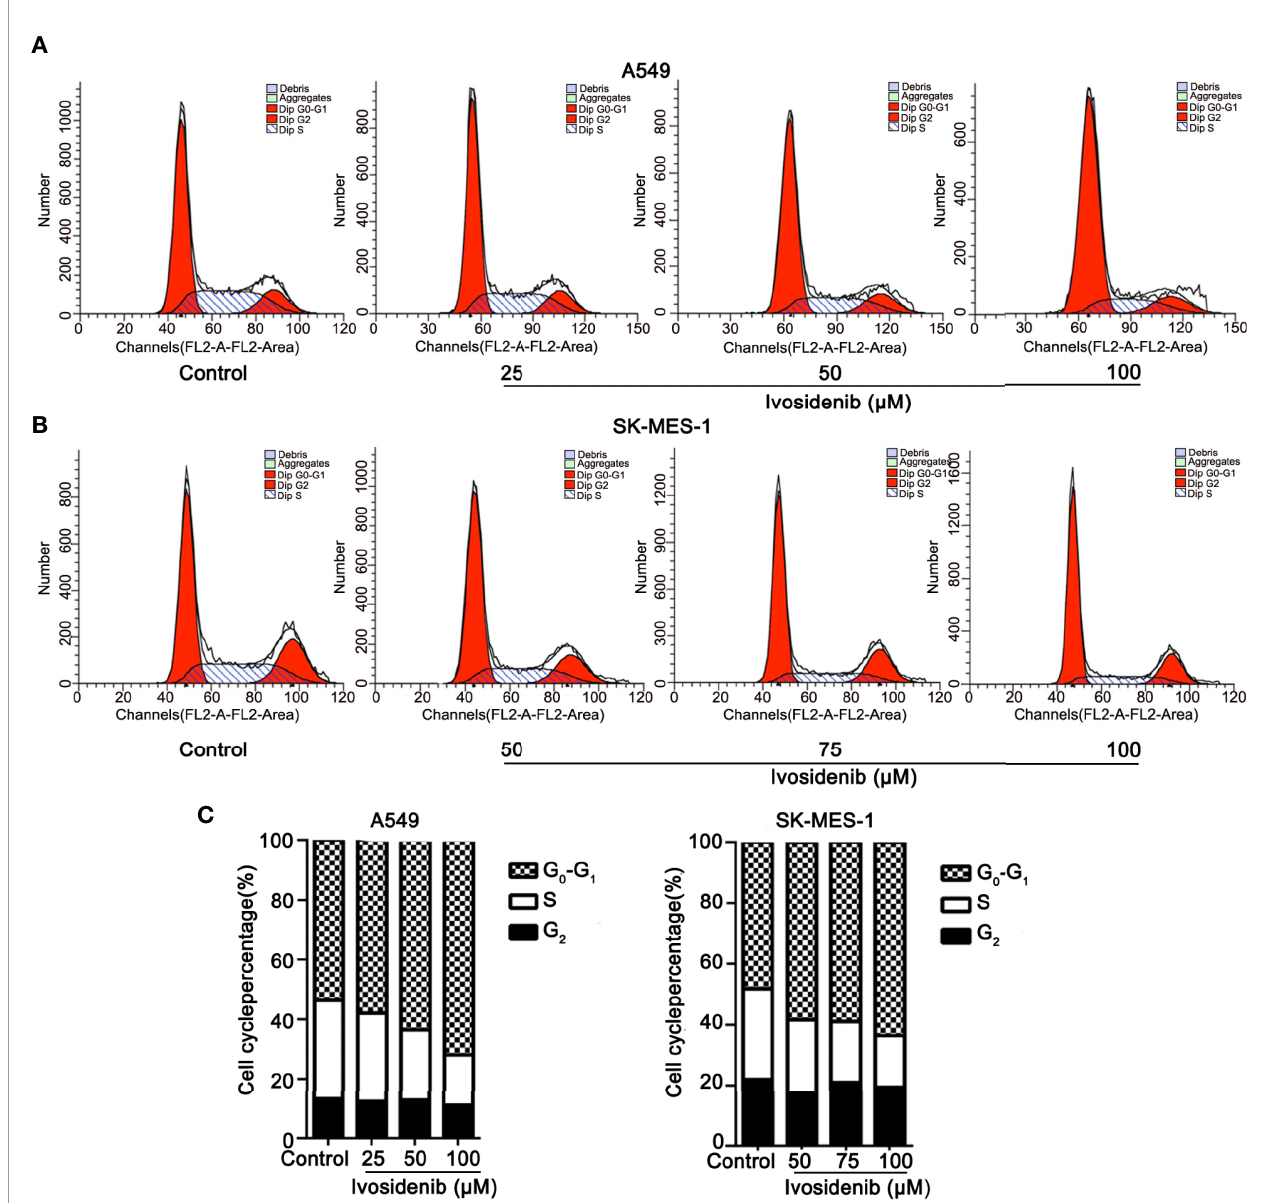
FIGURE 4 | Ivosidenib inhibits the cell cycle in NSCLC cells. (A) Flow cytometric analysis was used to measure cell cycle distributions of A549 cells after 24 h of culture with ivosidenib at 25, 50, and 100 µM. (B) Flow cytometric analysis was used to measure cell cycle distributions of SK-MES-1 cells after 24 h of culture with ivosidenib at 50, 75, and 100 µM. (C) The results are reported in the diagram. Data represent the means ± SD of three separate